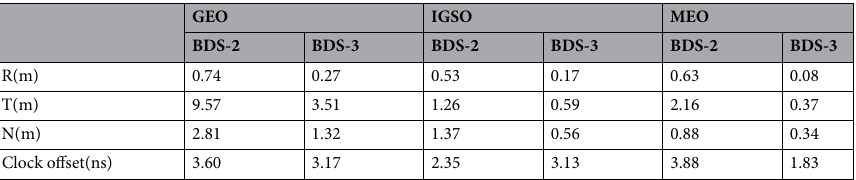
Table 4. Statistics of BeiDou orbit and clock offset accuracies. The results are derived from the averages of the corresponding values for all the same category of BDS-2 and BDS-3 satellites in Fig. 5, respectively.